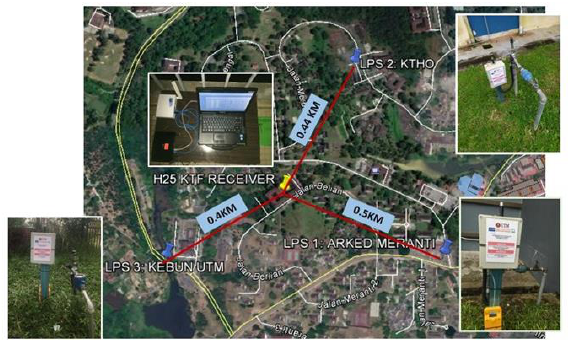
Figure 1. The location of sensors at UTM campus, Johor Bahru,